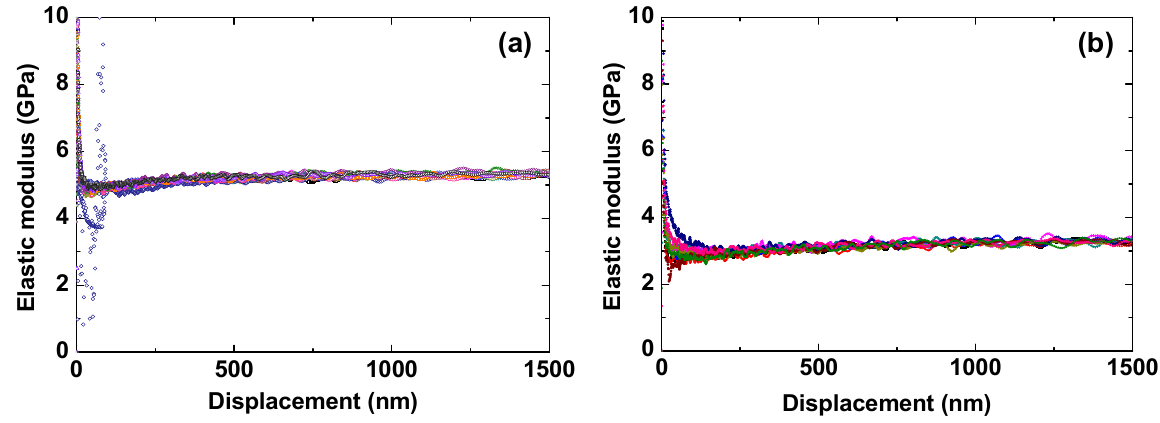
Figure 4. Elastic modulus of ( a ) PI and ( b ) PET substrates. Tests were conducted for 16 positions on samples.